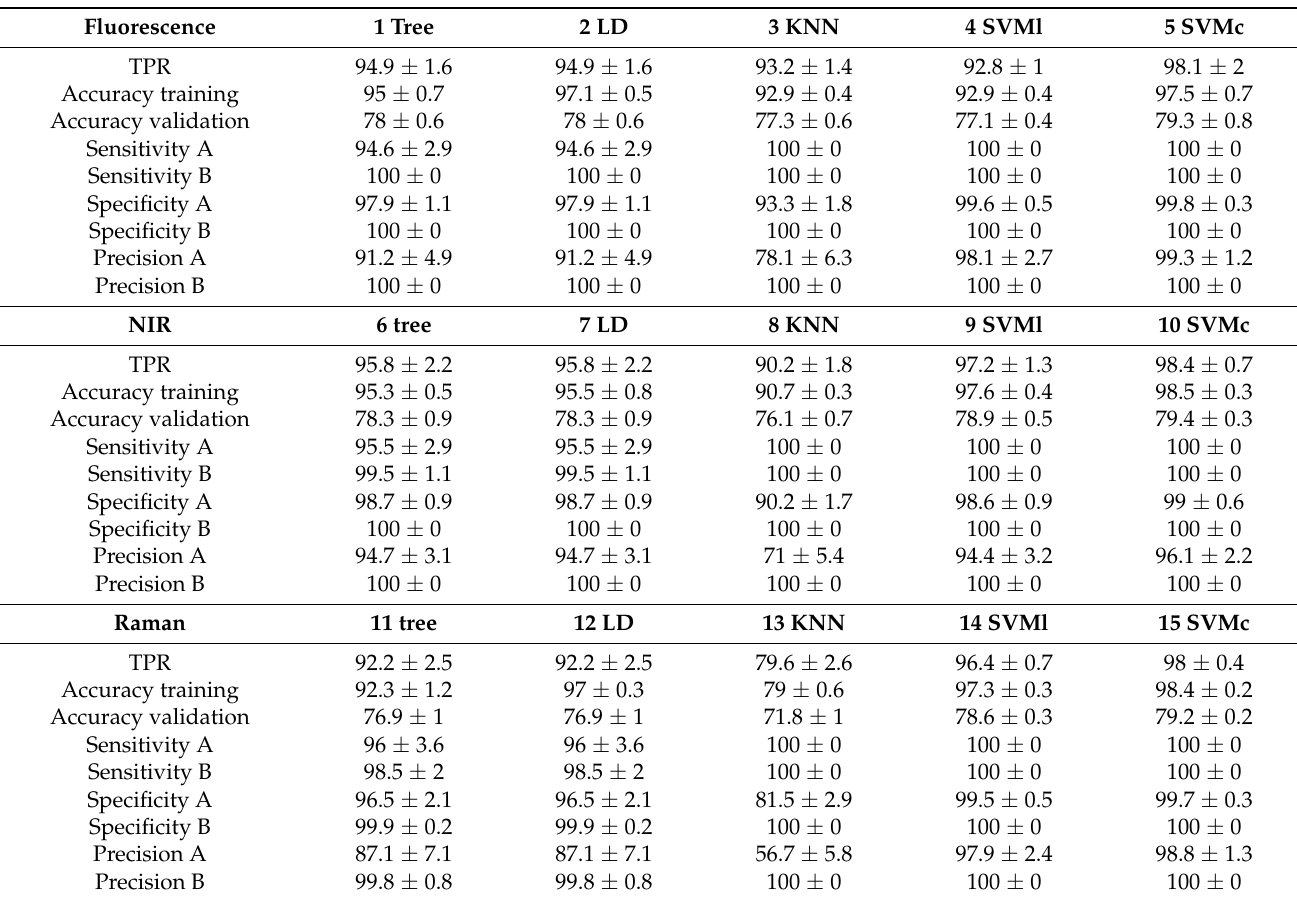
Table 4. Results of the classification of samples with single spectra; Means and standard deviations of 10 classification runs.